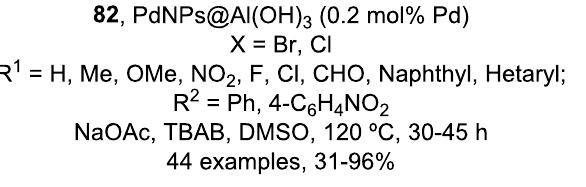
Figure 24. Titania and zinc oxide-immobilized PdNPs as catalysts for the Sonogashira reaction. Conditions, substrate scope and yield range (Scheme 2).